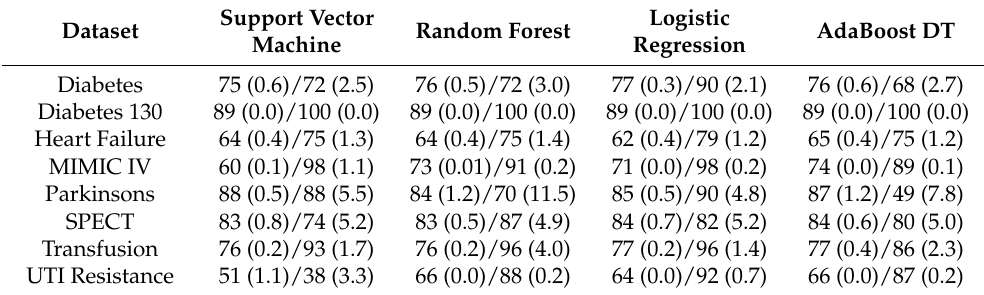
Table 1. Average overall accuracy (SD)/average error consistency (SD) for each ML model and dataset combination considered. All entries in the table report percentages. Sample sizes are provided in Section